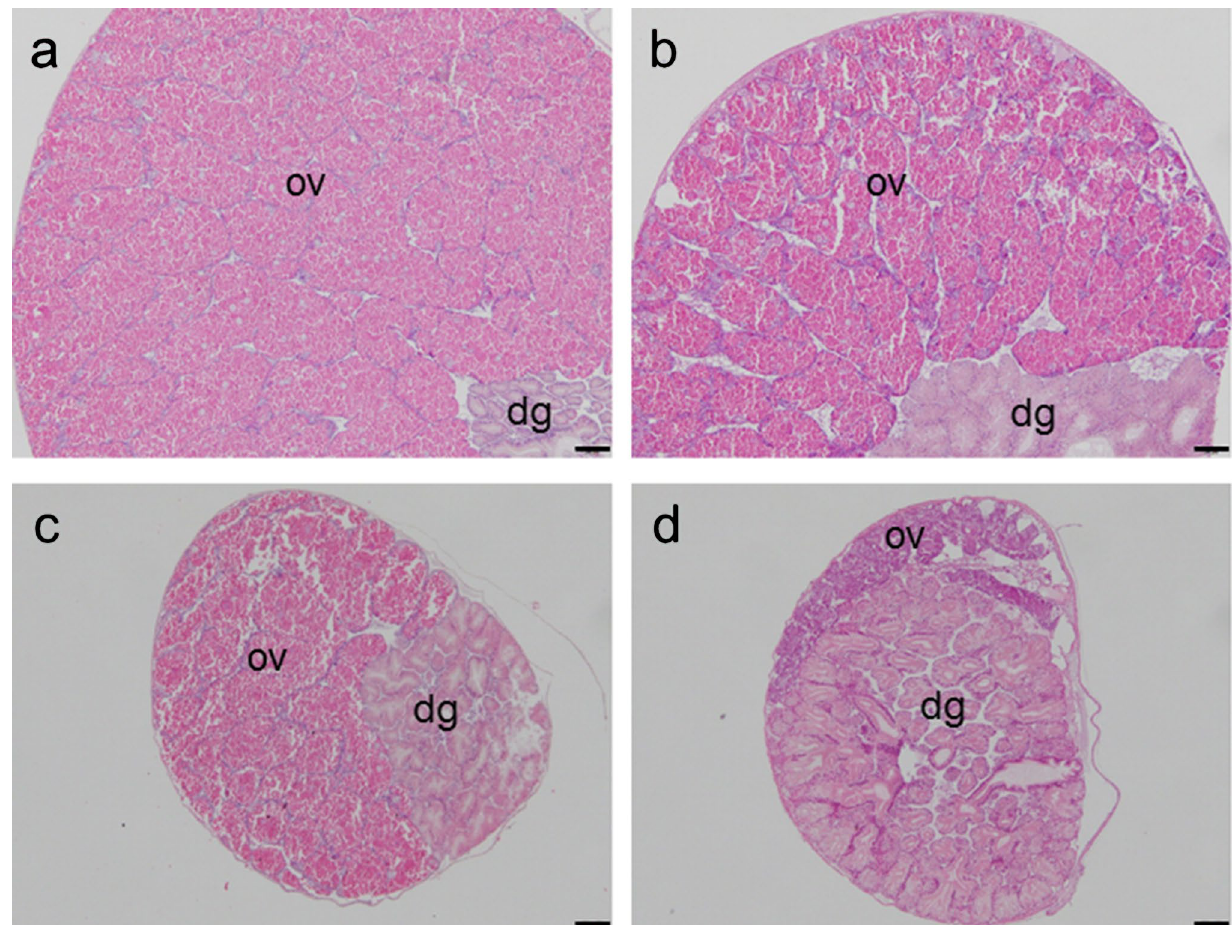
Figure 3. Examples of ovarian tissues of Thais clavigera collected at Okuma and Hiraiso. ( a ) Female T. clavigera collected at Okuma on 16 June 2018 in the reproductive season, ( b ) female T. clavigera collected at Okuma on 24 January 2019 in the non-reproductive season, ( c ) female T. clavigera collected at Hiraiso on 18 June 2018 in the reproductive season, and ( d ) female T. clavigera collected at Hiraiso on 25 January 2019 in the non-reproductive season. ov, ovary; dg, digestive gland. Bars = 200 µm. ( a )–( c ) Ovarian tissues are thick, and many mature oocytes can be seen. Therefore, we judged these ovaries to be mature (developmental grade III; see Table 1). ( d ) The ovarian tissue is thin, and oogonia and early stage oocytes are present, together with connective tissues and hemocytes. Therefore, we judged this ovary to be in the recovery stage (developmental grade I; see Table